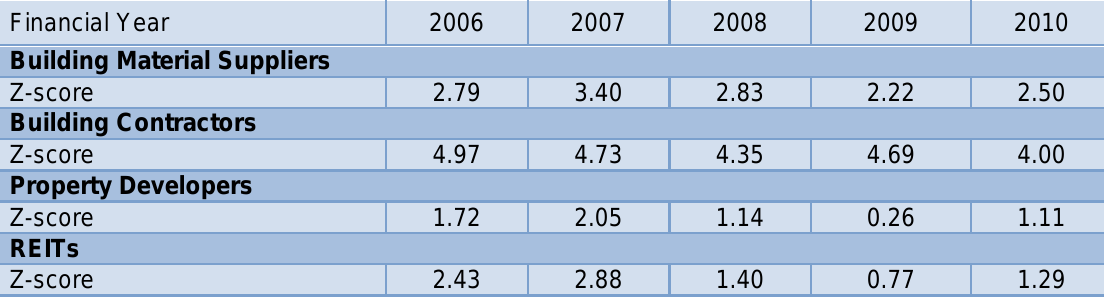
Table 4 Distress analysis (weighted on revenue) Discussion of